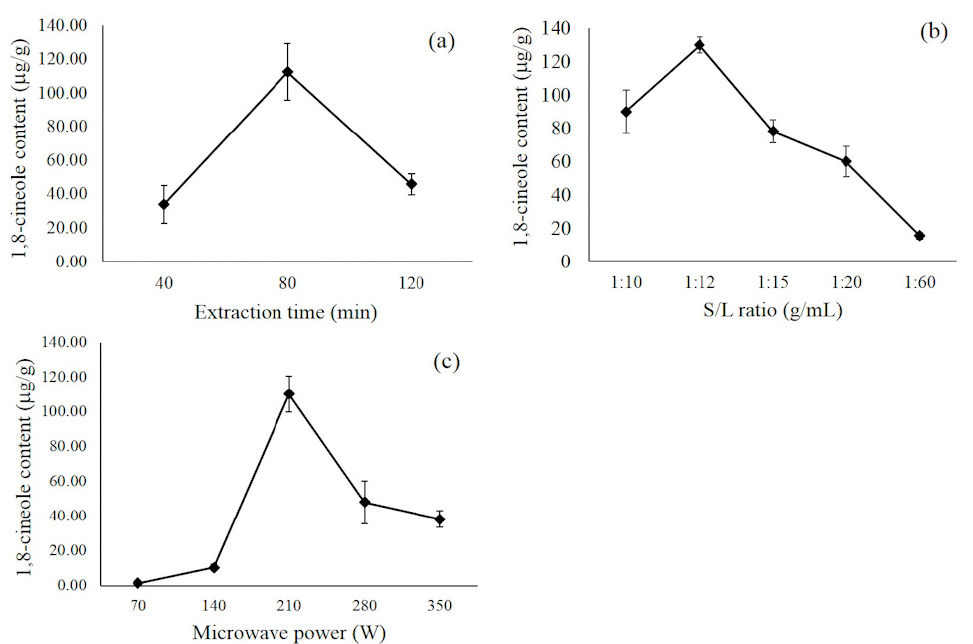
Figure 4. The e ff ect of extraction time ( a ), material-to-water ratio ( b ), and microwave power ( c ) on 1,8 cineole